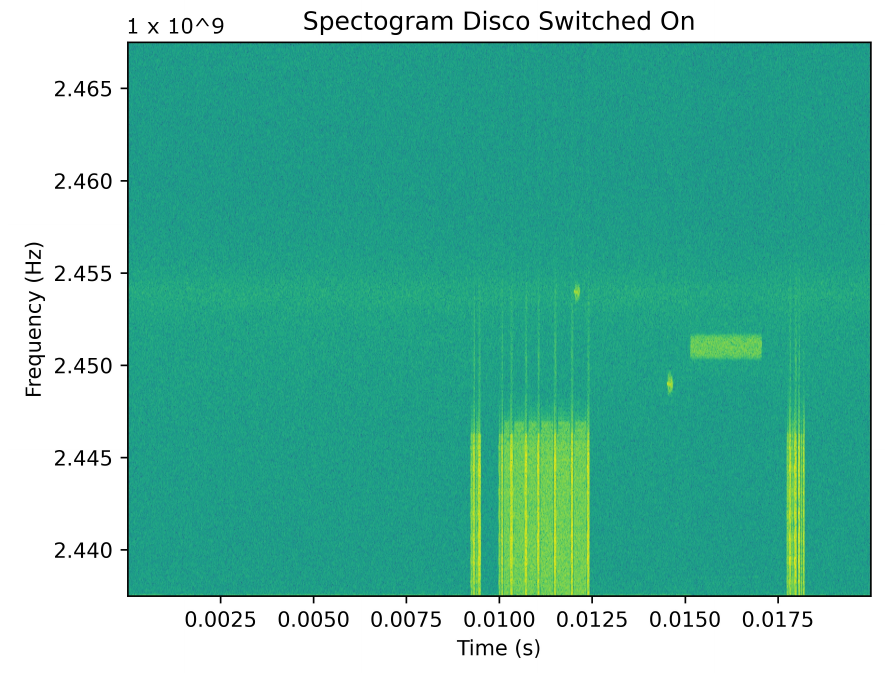
Figure 10. Spectrogram: Disco switched